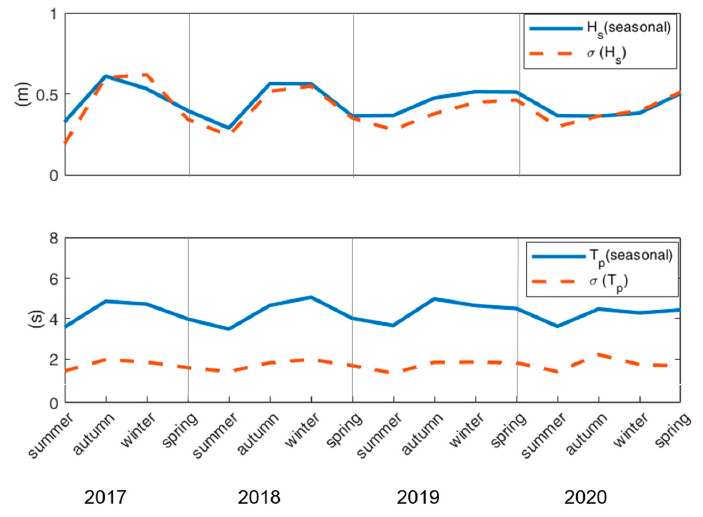
Figure 11. Seasonal distribution of the wave parameters in the years 2017–2020. The analysis of the identified storm events that occurred in the monitoring time frame Table 3. Distribution of the sea storm events in the years 2017–2020 according to the energy classification. (2017 to the beginning of 2021) shows that a total of 51 events occurred (Table A2). Of these, 9 events occurred in 2017, 15 in 2018, 13 in 2019 and 11 in 2020. Moreover, three events were recorded in the first two months of 2021. In detail, the annual percentage of sea storm events (Table 3) and the seasonal distribution of related energy (Figure 12) for complete years (2017 to 2020) indicate some differences among the years of observations: